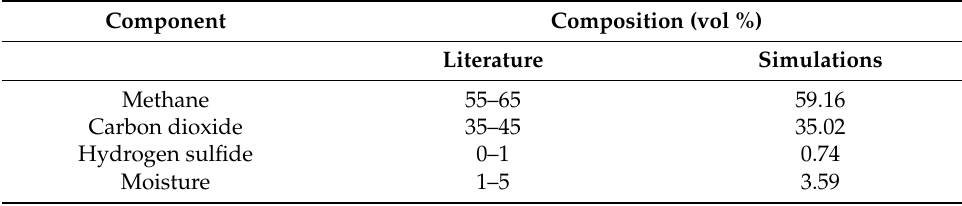
Table A4. Simulated biogas composition versus literature biogas composition.